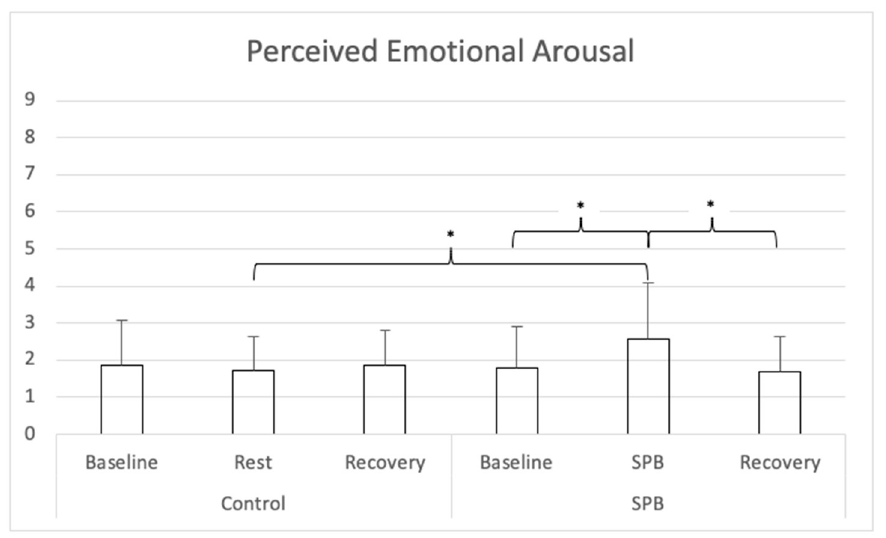
Figure 3. Perceived Emotional Arousal. Note: SPB: Slow-paced breathing; * p < 0.006 (Bonferroni correction).